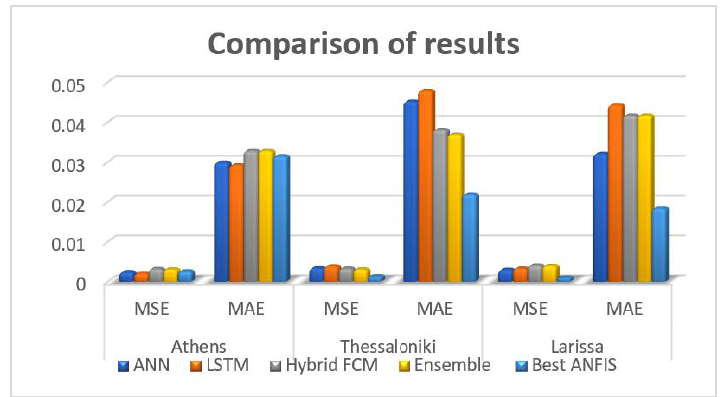
Figure 10. Comparison of results between machine learning and soft computing methods for three benchmark cities.